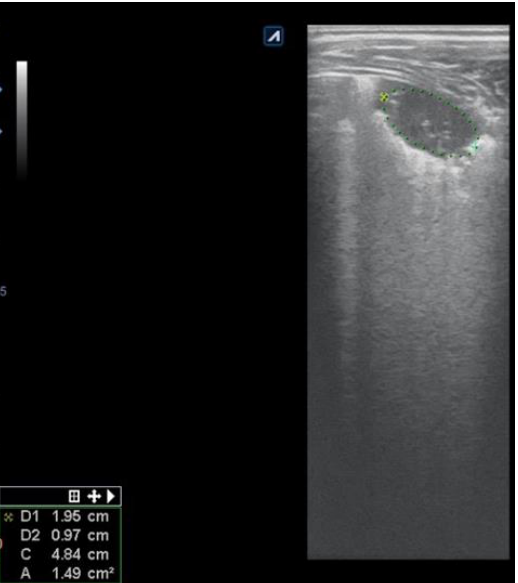
Figure 8. Subpleural consolidation, with air inside ; dimensions: 1.96 cm/0.97 cm, 7 – 12 MHz linear transducer.